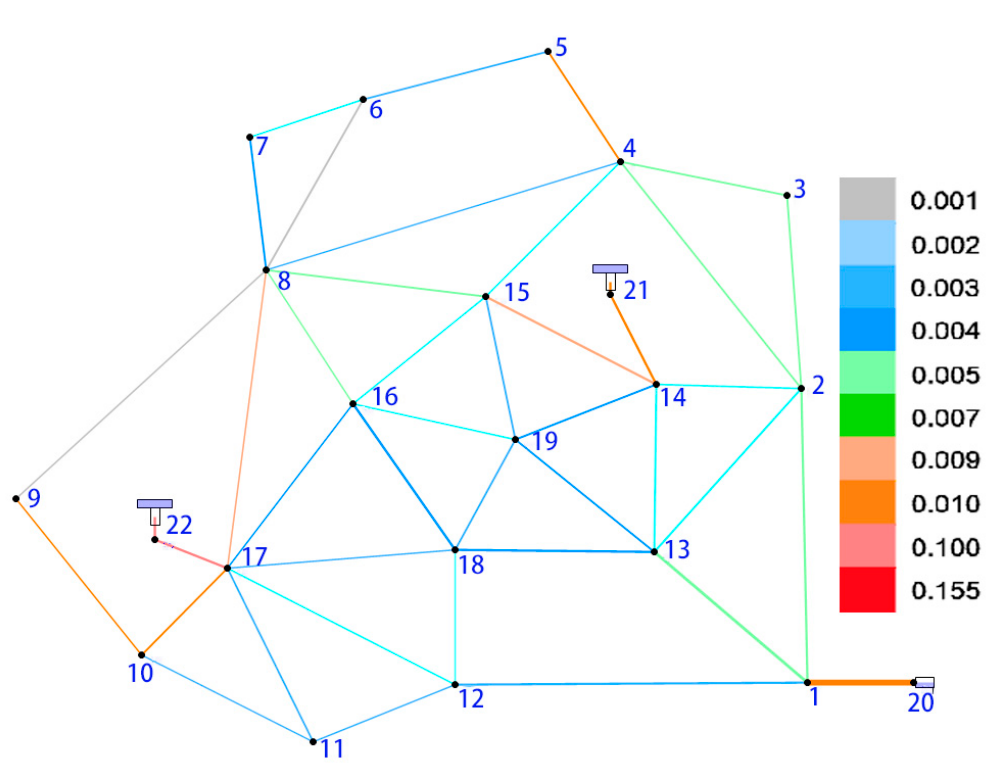
Figure 2. UIPF assessment of Anytown network .